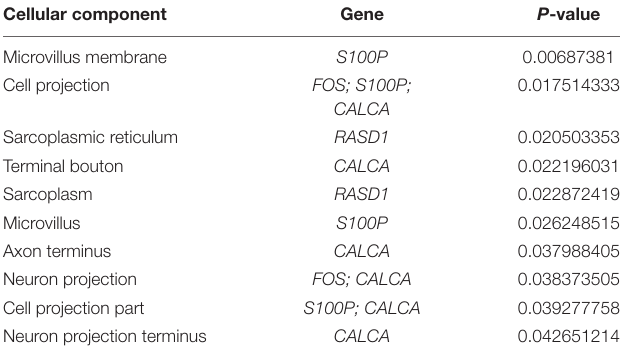
TABLE 2 | Gene ontology cellular component enrichment